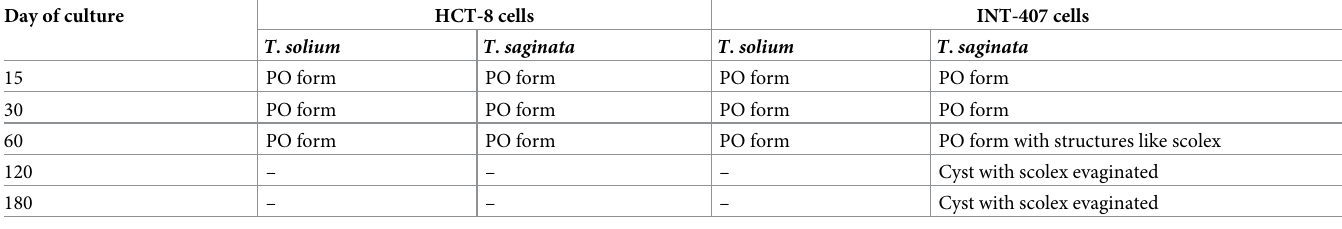
Table 1. Oncospheres of T . solium and T . saginata cultured in HCT-8 and INT-407 cells during 180 days. Day of